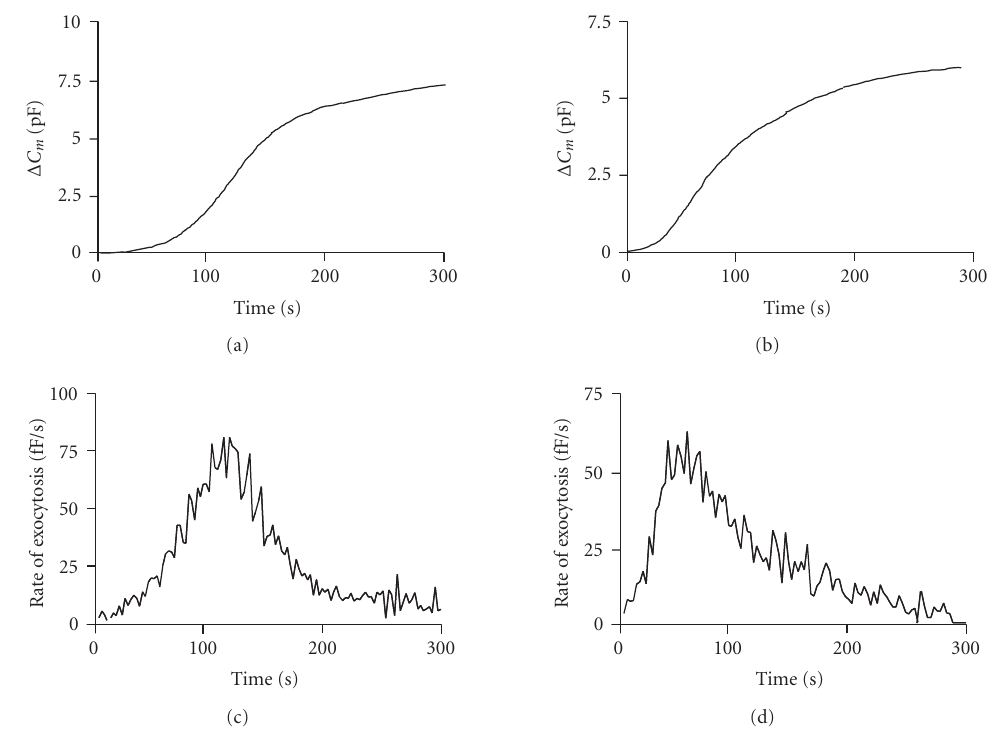
Figure 4: Neutrophil secretion is monophasic. The rate of capacitance increase during neutrophil exocytosis is induced by [Ca 2+ ] i of 100 µ M (left) and 300 µ M (right), respectively. (a) and (b) show the capacitance recordings of two representative experiments, and (c) and (d) show the rates of exocytosis, determined as the derivatives of these capacitance curves. No cells ( n = 50) showed two peaks in the derived traces. No direct comparisons were made between the two pairs of traces (a and c versus b and d) making it possible to use scales that accurately show each individual